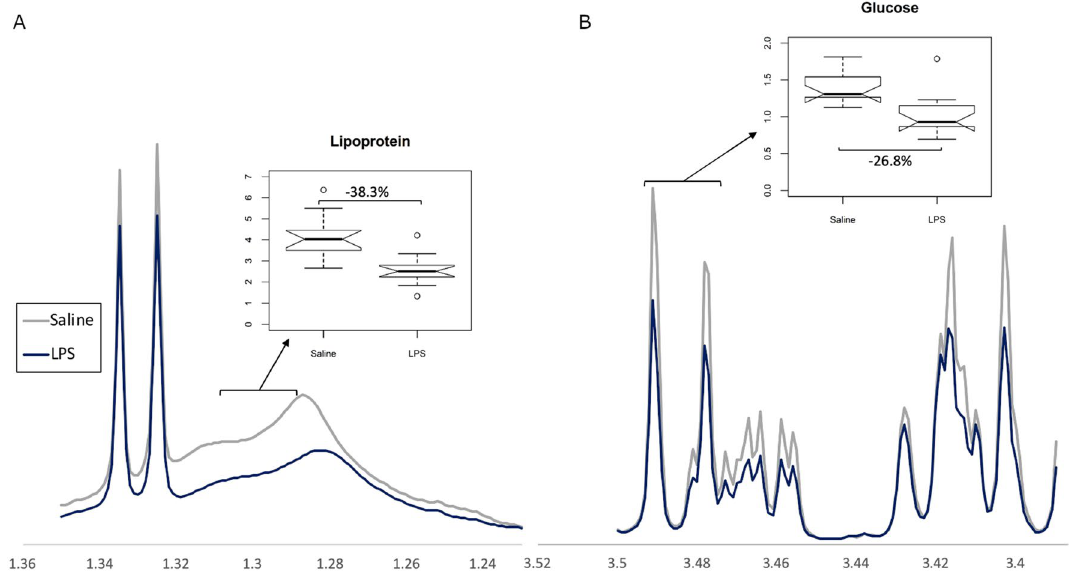
Figure 5. Representative images of NMR spectra showing group differences between ( A ) a lipoprotein bin and ( B ) a glucose bin. Spectra expressed as average of treatment